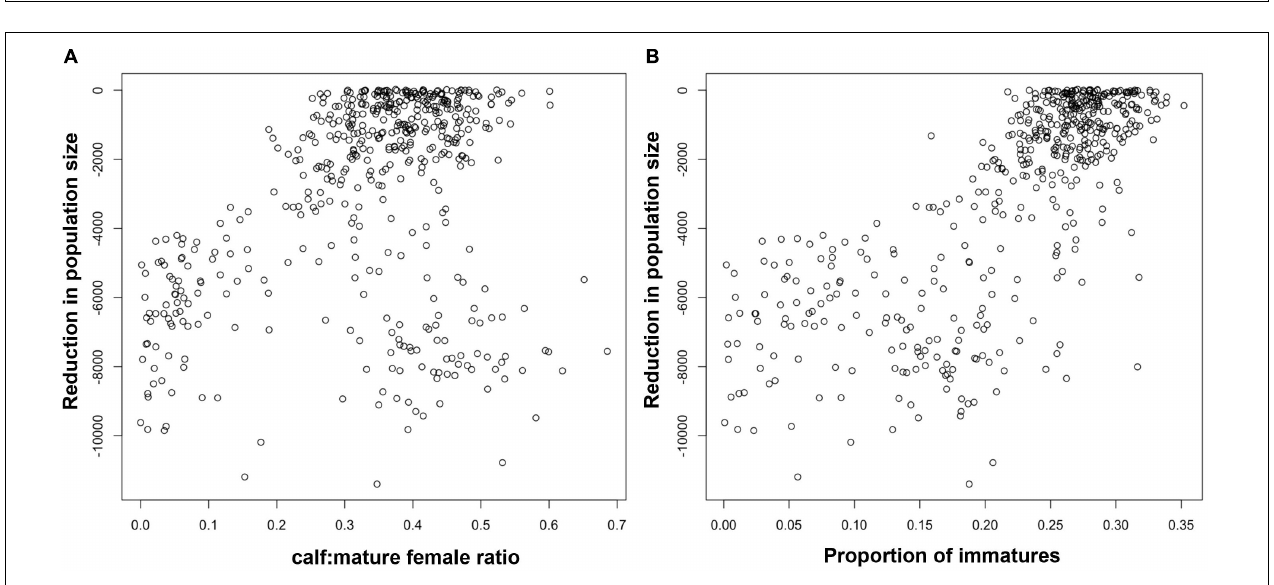
FIGURE 2 | Relationship between the maximum predicted reduction in harbor porpoise population size and (A) the ratio of calves to mature females in year 3, and (B) the proportion of immature animals in year 5.